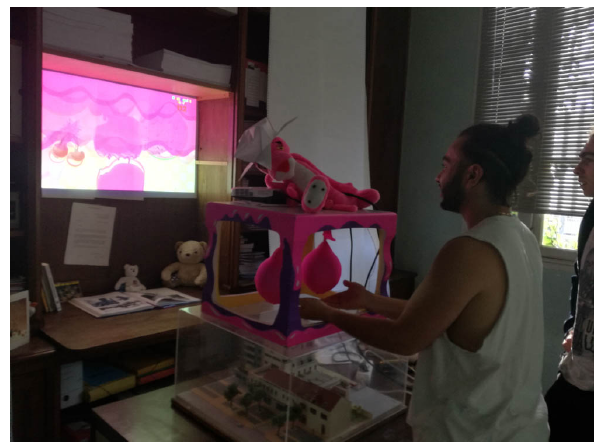
Figure 2. Huge balls version.2 in the exhibition Malakoniarof in Malakoff, 2018.